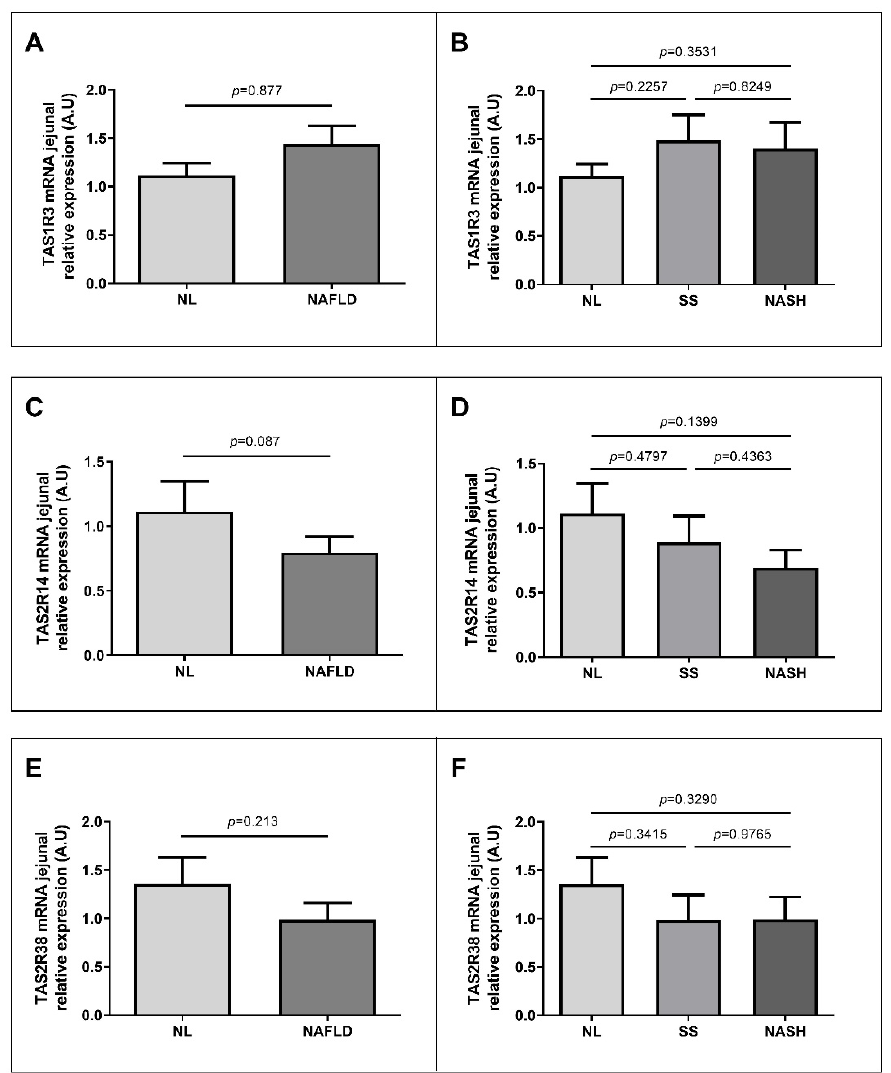
Figure 3. Differential JRE of TAS in women with morbid obesity classified according to hepatic histopathological classification. ( A ) TAS1R3 JRE of NL and NAFLD subjects; ( B ) TAS1R3 JRE of NL, SS and NASH groups; ( C ) TAS2R14 JRE of NL and NAFLD subjects; ( D ) TAS2R14 JRE of NL, SS and NASH groups; ( E ) TAS2R38 JRE of NL and NAFLD subjects; ( F ) TAS2R38 JRE of NL, SS and NASH groups. TAS, taste receptors; NL, normal liver; NAFLD, nonalcoholic fatty liver disease; SS, simple steatosis; NASH, nonalcoholic steatohepatitis; TAS1R3, taste 1 receptor family 3; TAS2R14, taste 2 receptor family 14; TAS2R38, taste 2 receptor family 38; A.U, arbitrary units. p < 0.05 was considered statistically significant.